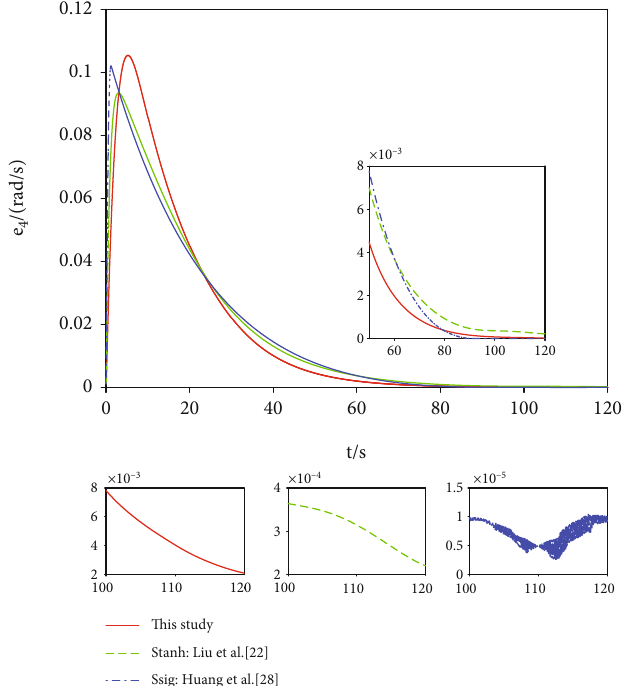
Figure 13: Relative angular velocity error